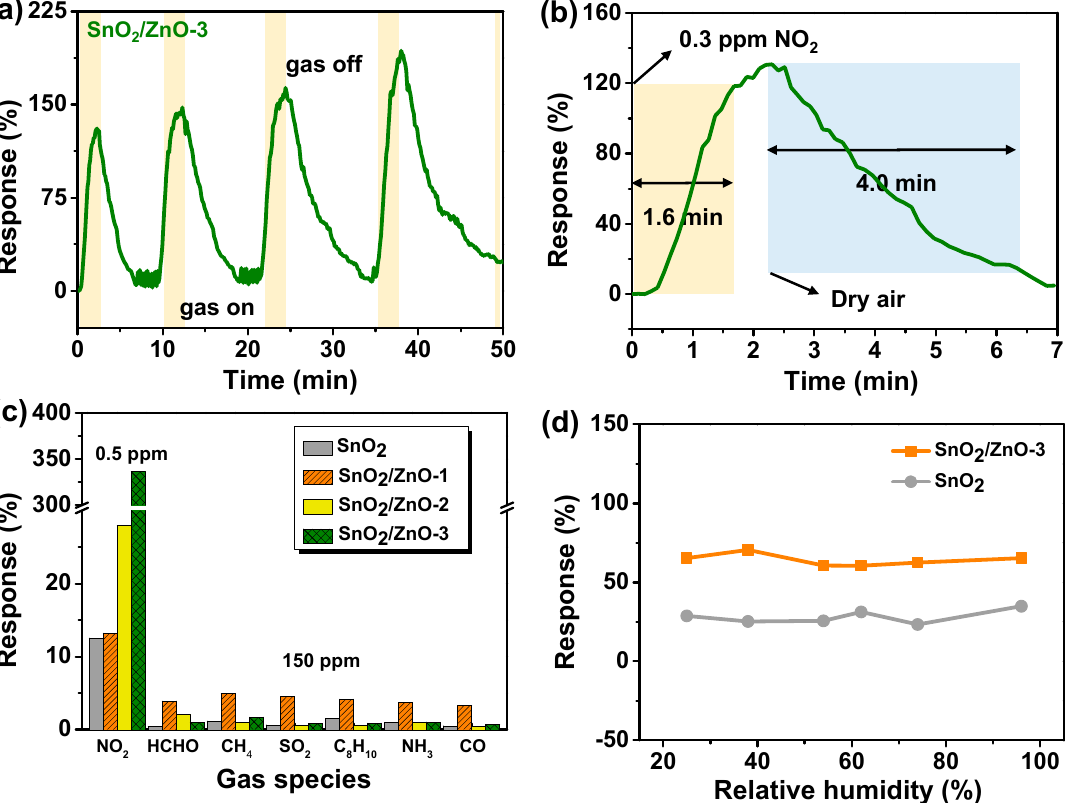
Figure 7. ( a ) Dynamic response of SnO 2 /ZnO-3 gas sensors to 0.3 ppm NO 2 for four successive cycles. ( b ) Response and recovery time of SnO 2 /ZnO-3 gas sensors to 0.3 ppm NO 2 . ( c ) Selectivity of as-prepared samples sensors to 0.5 ppm NO 2 and 150 ppm other gases (HCHO, CH 4 , SO 2 , C 8 H 10 , NH 3 , CO) under the same measurement condition. ( d ) Response vs. relative humidity of SnO 2 , SnO 2 /ZnO-3 sensors in 0.3 ppm NO 2 .